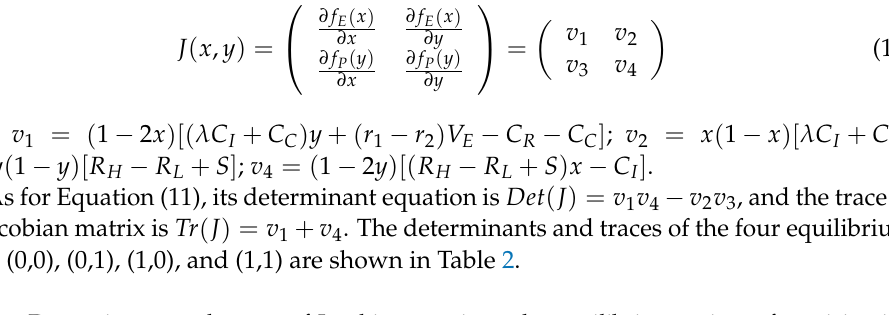
Table 2. Determinants and traces of Jacobian matrix at the equilibrium points of participation behavior decision in PPPs.